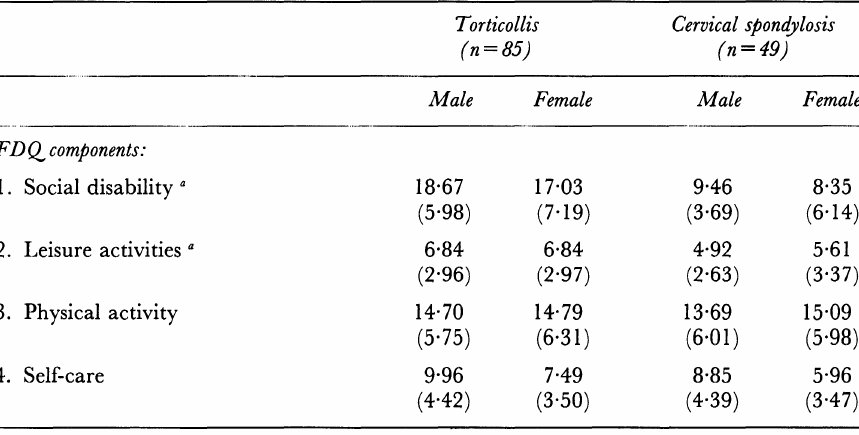
TABLE 2. Mean and standard deviation scores (in parentheses) of the torticollis and cervical spondylosis patients on the Functional Disability Questionnaire (FDQ)